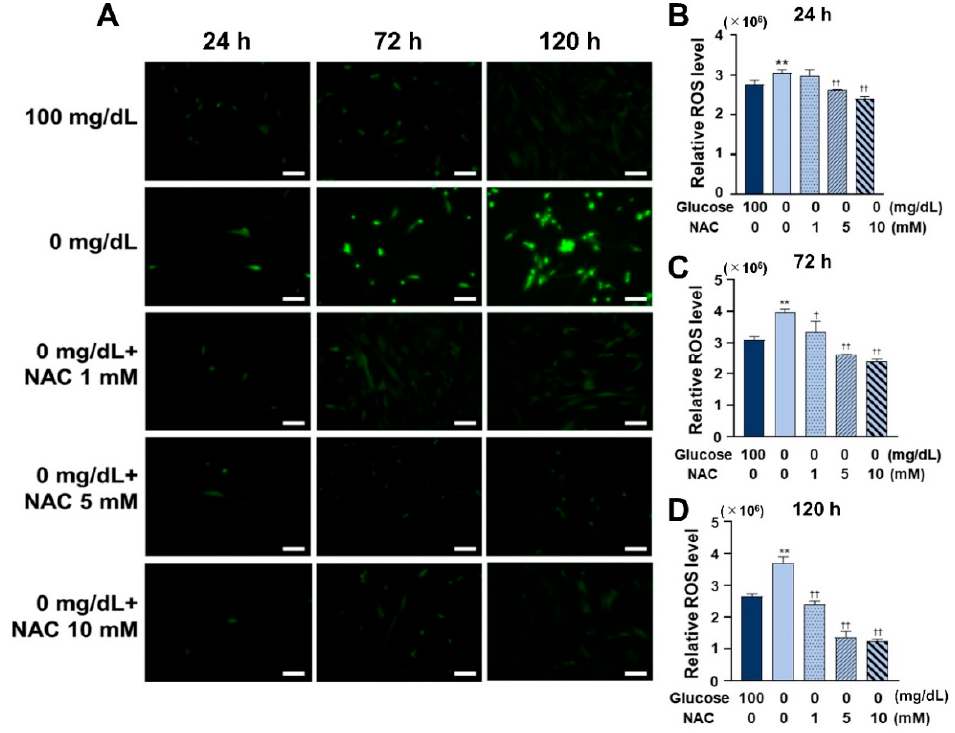
Figure 4. Effect of NAC on ROS formation and anti-ROS ability under low glucose conditions. ( A ) The total ROS of the HGnFs was stained and photographed under a fluorescence microscope after adding 1, 5, and 10 mM NAC and incubating for 24, 72, and 120 h. ( B – D ) Total ROS levels after 24, 72, and 120 h of incubation with 1, 5, and 10 mM of NAC were measured using a fluorescent microplate reader, and the results were modified relative to 100 mg/dL (control group). (Scale bars: 100 μ m; a significant increase compared with the control was described as ** p < 0.01; a significant decrease compared with the 0 mg/dL was described as † p < 0.05, †† p < 0.01) .